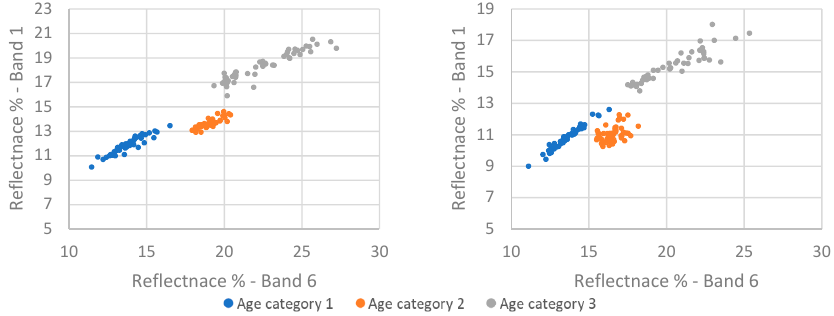
Figure 11. Band 1/Band 6 graphs for spectroradiometer ( left ) and colorimeter ( right ).